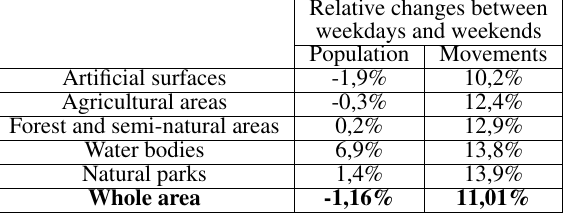
Table 2. Relative changes in percentage of average users’ population and movements in weekends with respect to